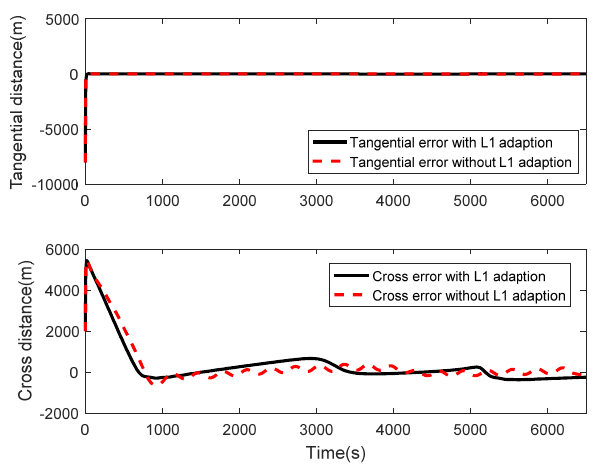
Figure 5. Tangential and cross errors with and without 𝐿 (cid:2869) adaptive control.